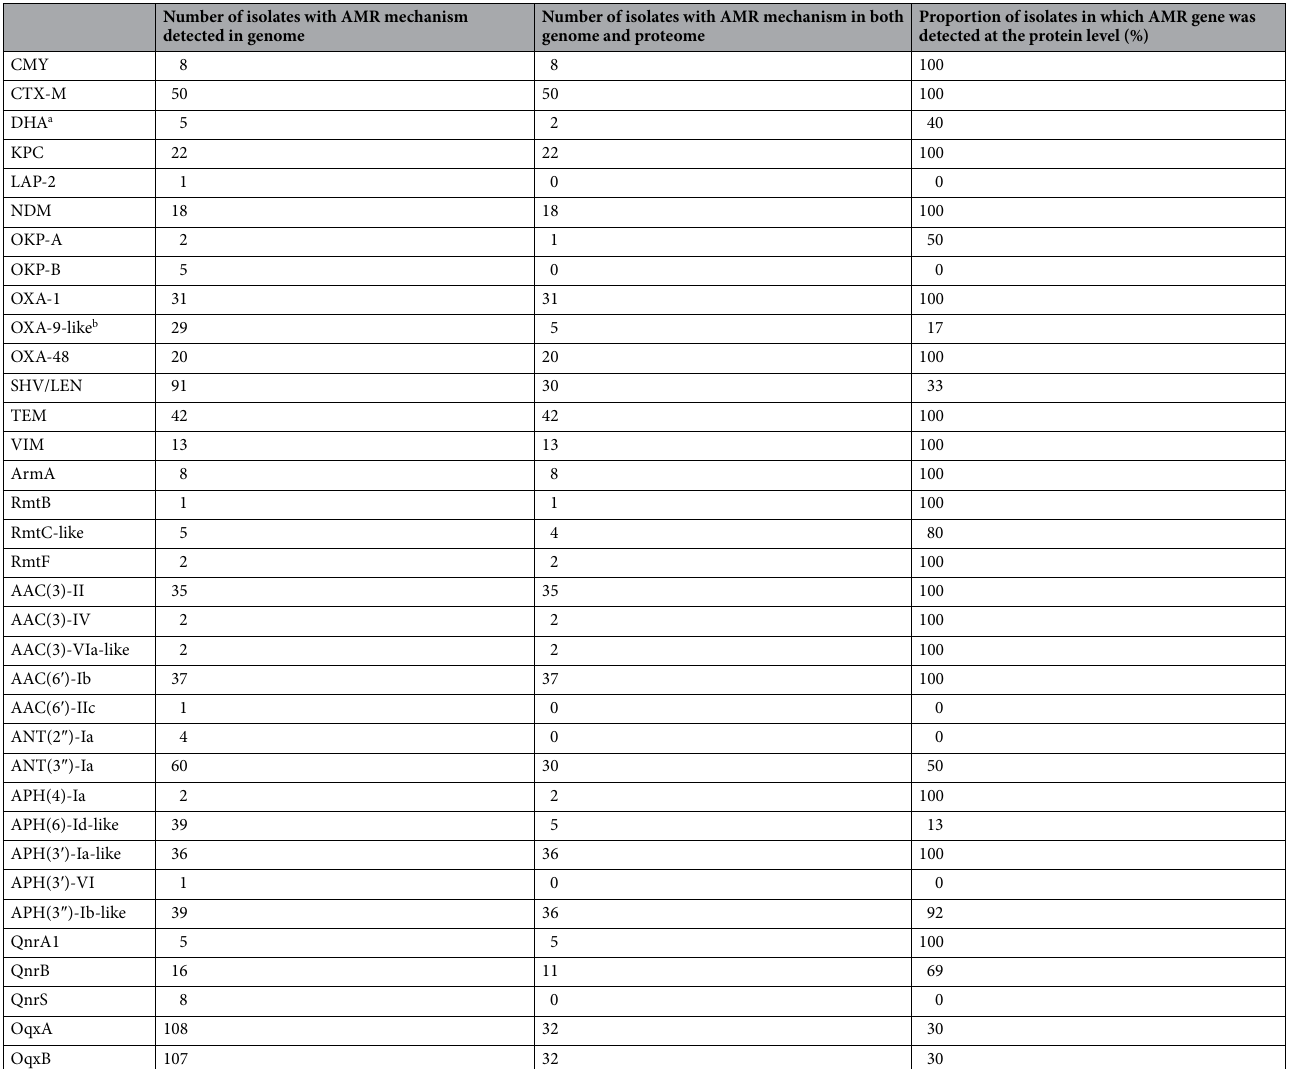
Table 2. Presence of genes and proteins of beta-lactamases, 16S ribosomal RNA methyltransferases, aminoglycoside modifying enzymes, quinolone resistance proteins and OqxAB efflux pumps in the